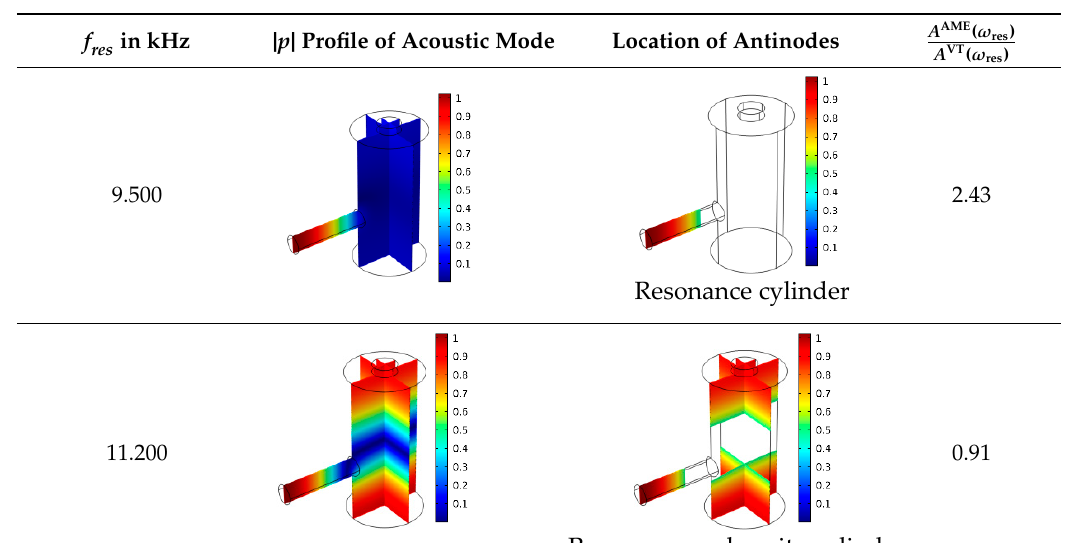
Table 3. Resonance frequency, corresponding mode, location of strong antinodes, and amplitude ratio for the 14 strongest resonances. The location of the antinodes was determined by lifting the lower limit of the depicted data range appropriately.